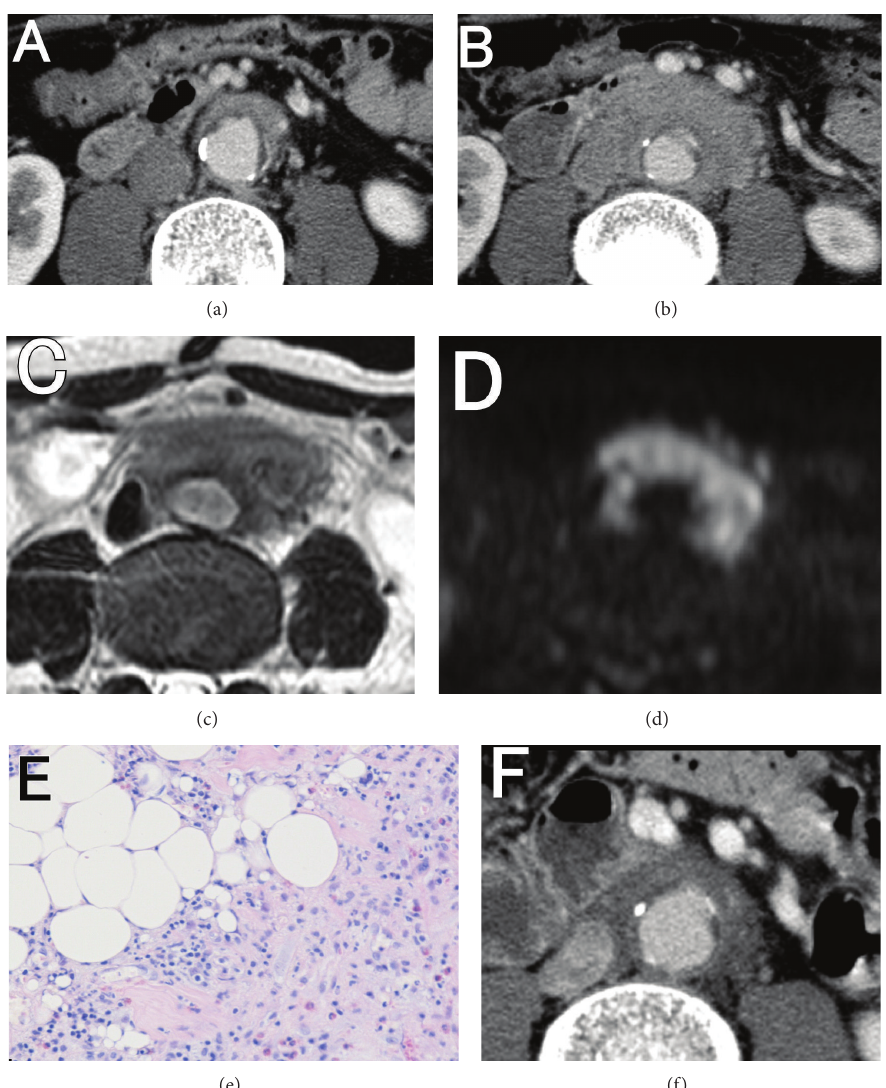
Figure 1: (a) A contrast-enhanced CT image, upon presentation. (b) A contrast-enhanced CT image two months after the presentation. (c) Low-intensity enhancement was observed in a T2-weighted, gadolinium-enhanced magnetic resonance image (MRI). (d) High-intensity was observed in the diffusion-weighted image. (e) A biopsy of the tissue revealed the infiltration of inflammatory cells and the absence of bacteria. (f) A contrast-enhanced CT image taken 3 weeks after starting the glucocorticoid